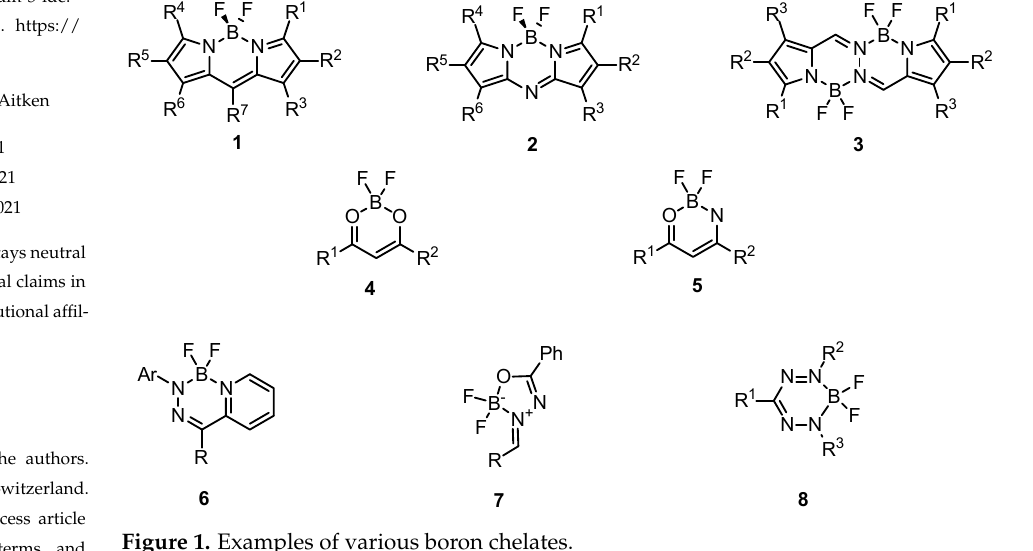
Figure 1. Examples of various boron chelates.